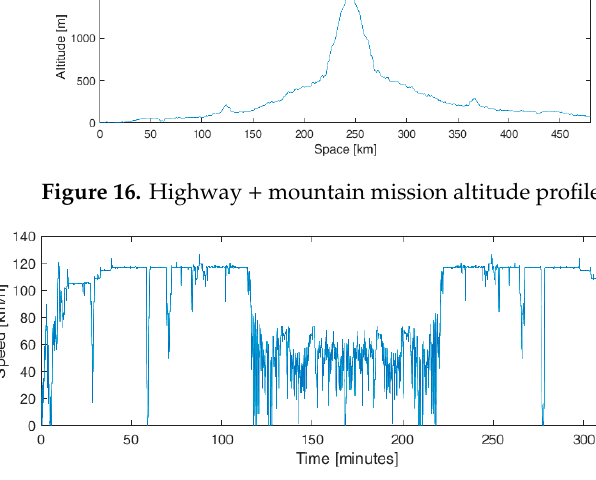
Figure 17. Highway + mountain mission speed profile.